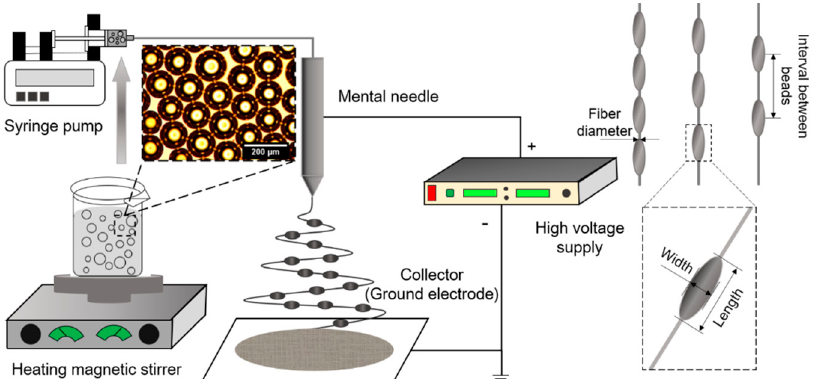
Figure 1. Schematic diagram of an electrospinning (ES) apparatus for beaded fiber engineering and graphical illustration of the key fiber properties assessed in this study.